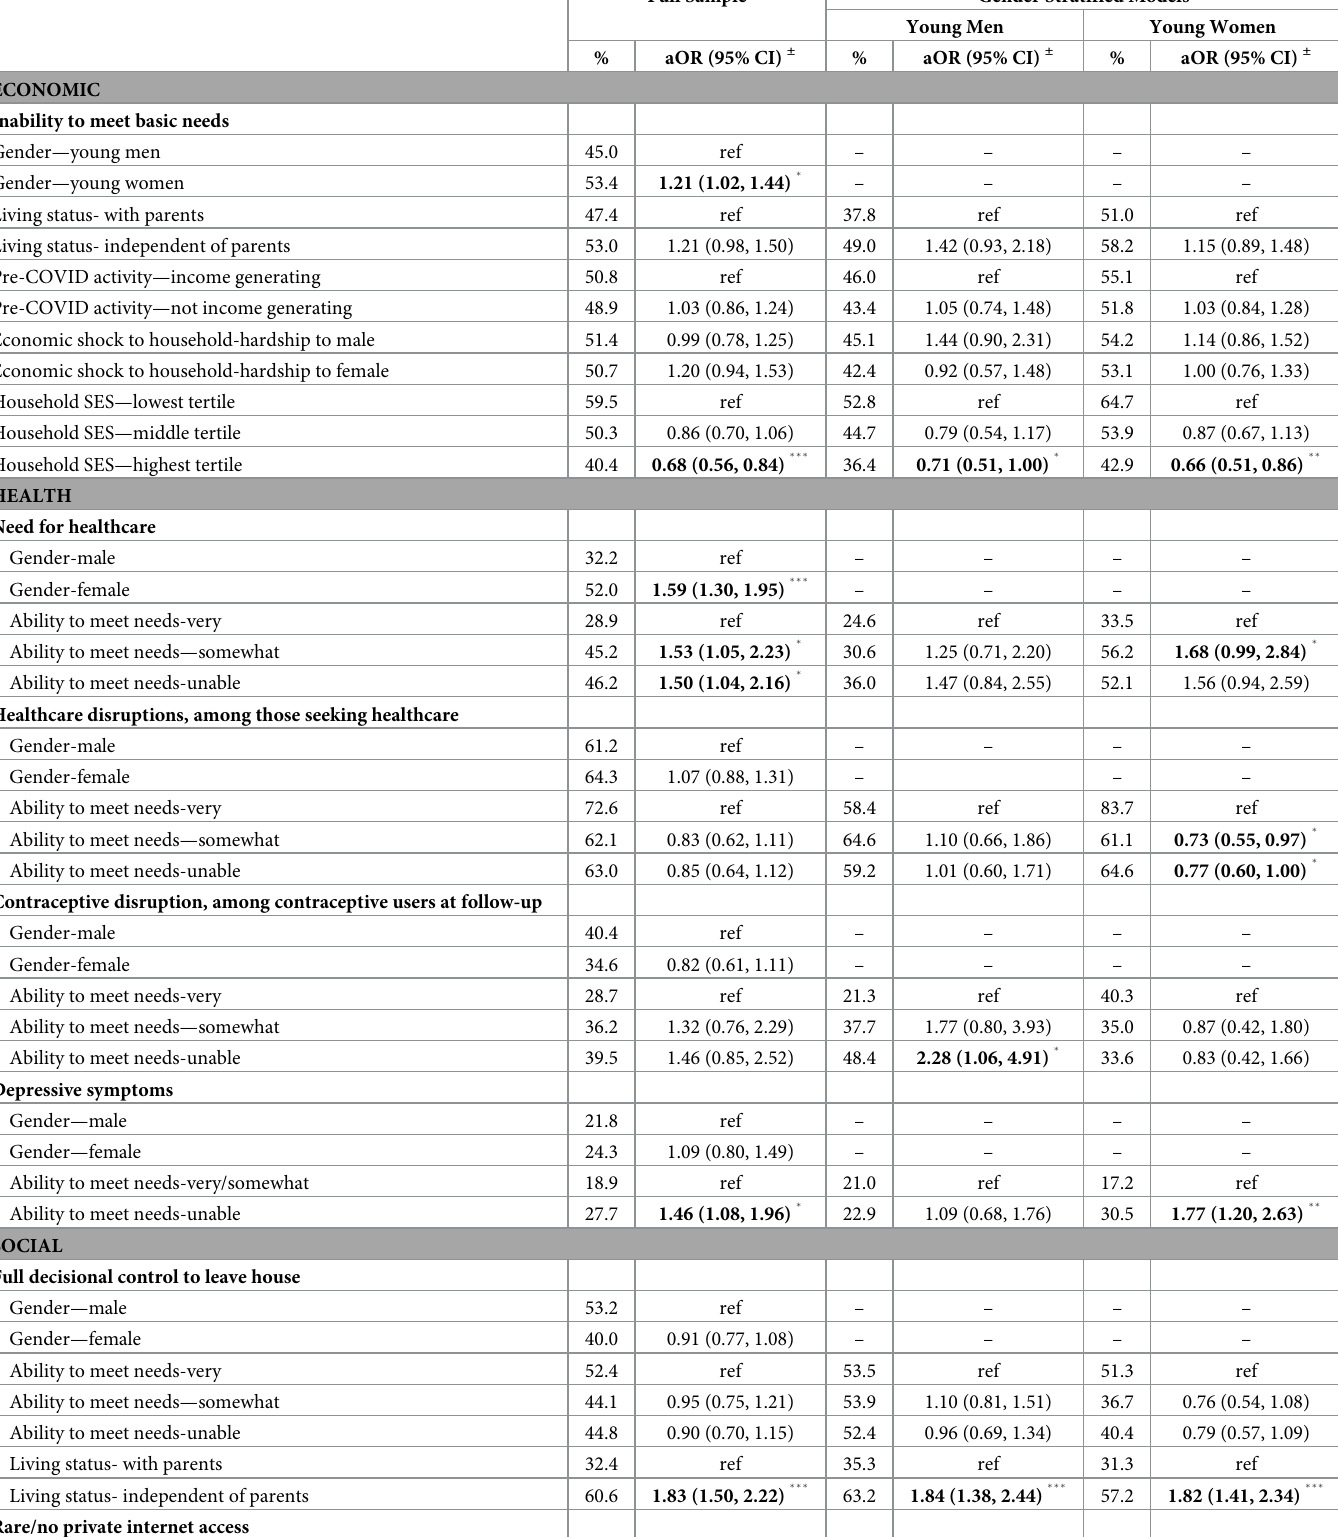
Table 3. Multivariable logistic regression of key health, economic, social, and safety indicators, combined and gender-stratified,